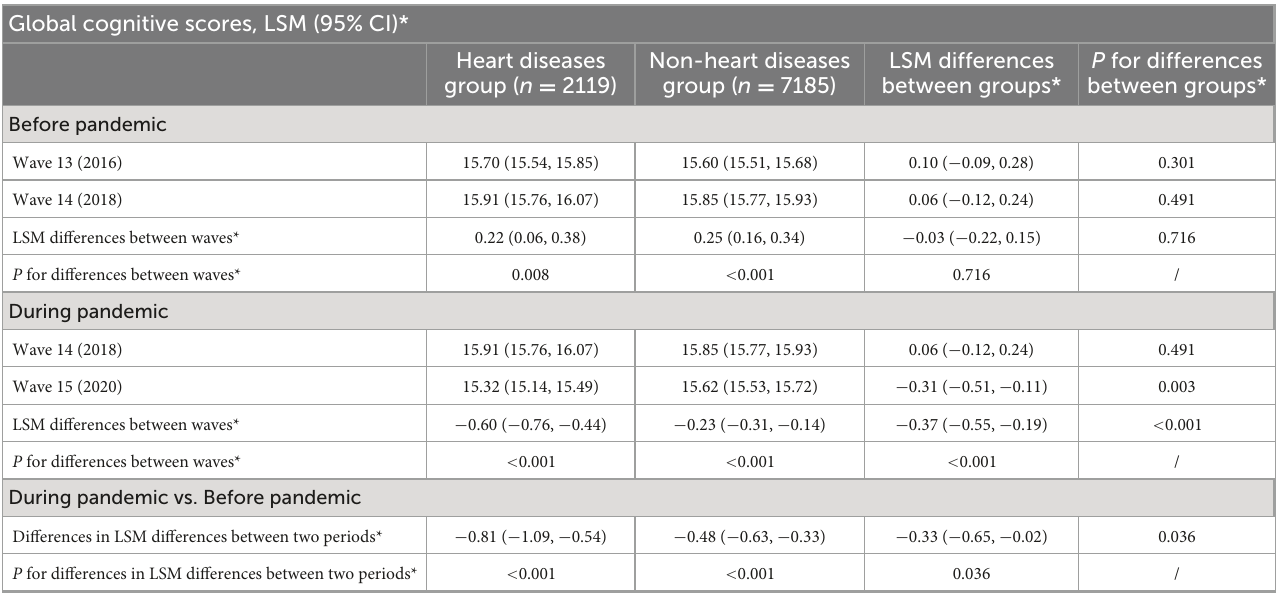
TABLE 2 Differences in the changes of global cognitive scores before and during the pandemic period, by heart disease status. Global cognitive scores, LSM (95% CI)*